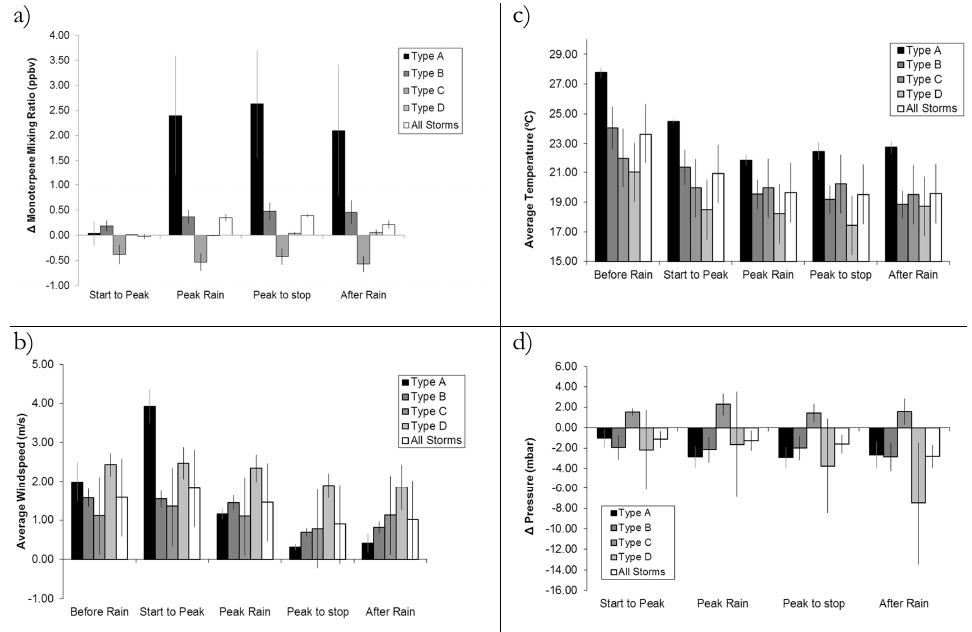
Fig. 8. The averages during each phase of the different types of storms. (a) The change in mixing ratio of monoterpenes, (b) wind speed, (c) temperatures, (d) change in atmospheric pressure as storm systems pass over Thompson